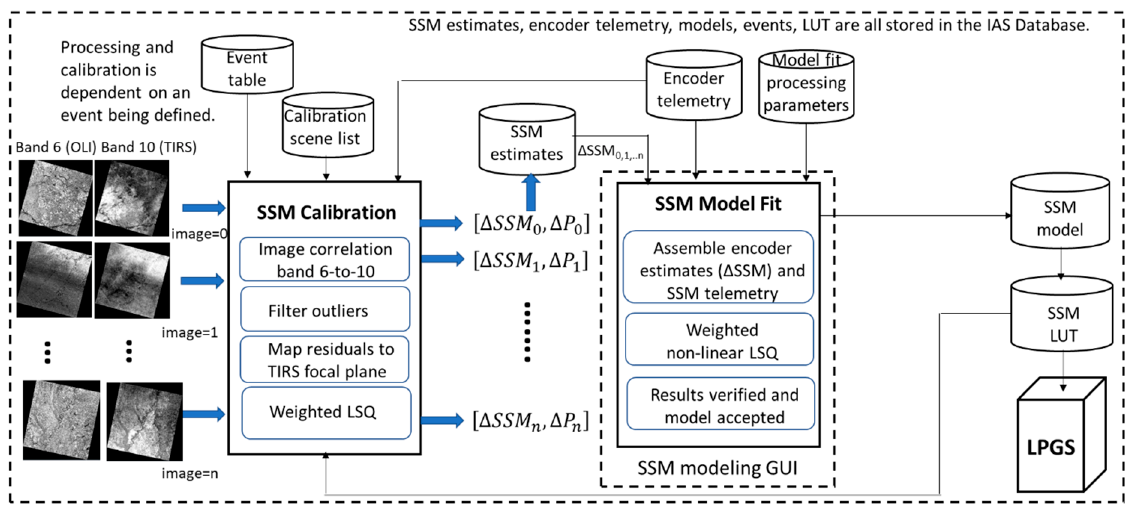
Figure 3. Processing flow for TIRS scene select mechanism (SSM) geometric calibration. Geometric calibration sites, precision and terrain, and corrected images are used to measure OLI-to-TIRS misalignments that feed the SSM modeling steps. When an adequate number of cloud-free calibration sites are acquired and an SSM model can be determined, new TIRS-to-OLI alignment parameters can be pushed to the Landsat product generation system (LPGS) for product generation. LUT is a lookup table of encoder values used in product generation. LSQ is the non-linear least squares fitting performed on the encoder and image measurements. GUI is the graphical user interface used by the calibration analyst for viewing the SSM encoder function against the encoder and image measurements. Δ P refers to the residual pitch alignment determined from the SSM calibration.